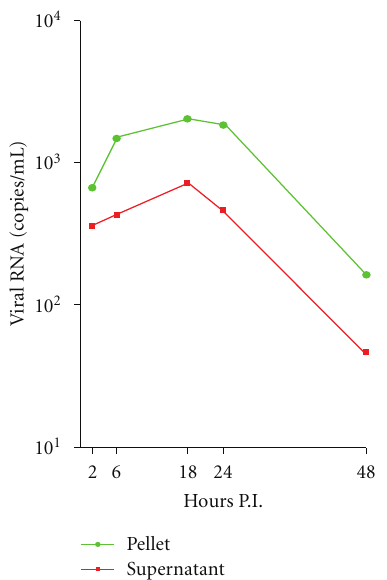
Figure 4: Transient replication of dengue virus in platelets . Platelets were isolated from a healthy donor and experimentally infected with dengue virus serotype 2 (strain 16681) at an MOI of 0.01. RNA was isolated from supernatants and pellets at indicated time and subjected to real-time qRT-PCR for dengue viral